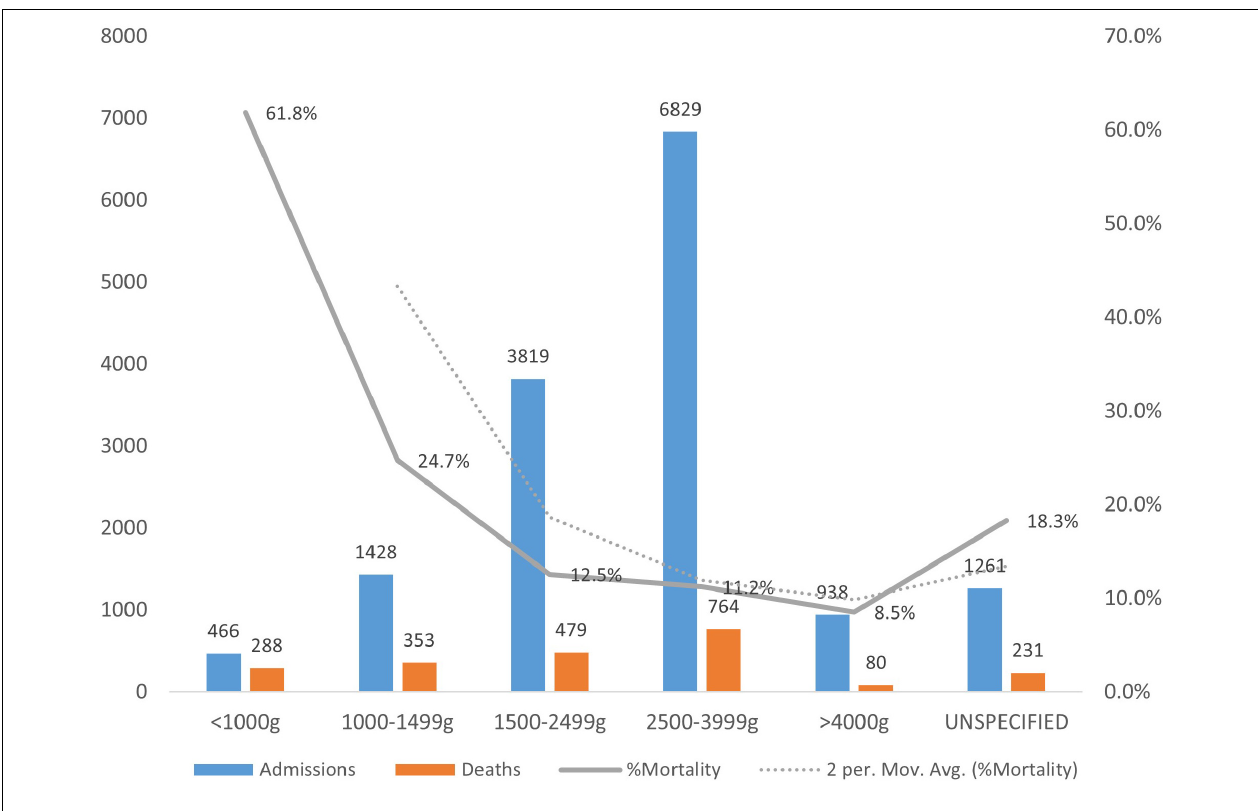
FIGURE 6 | Trend in morbidity and mortality based on